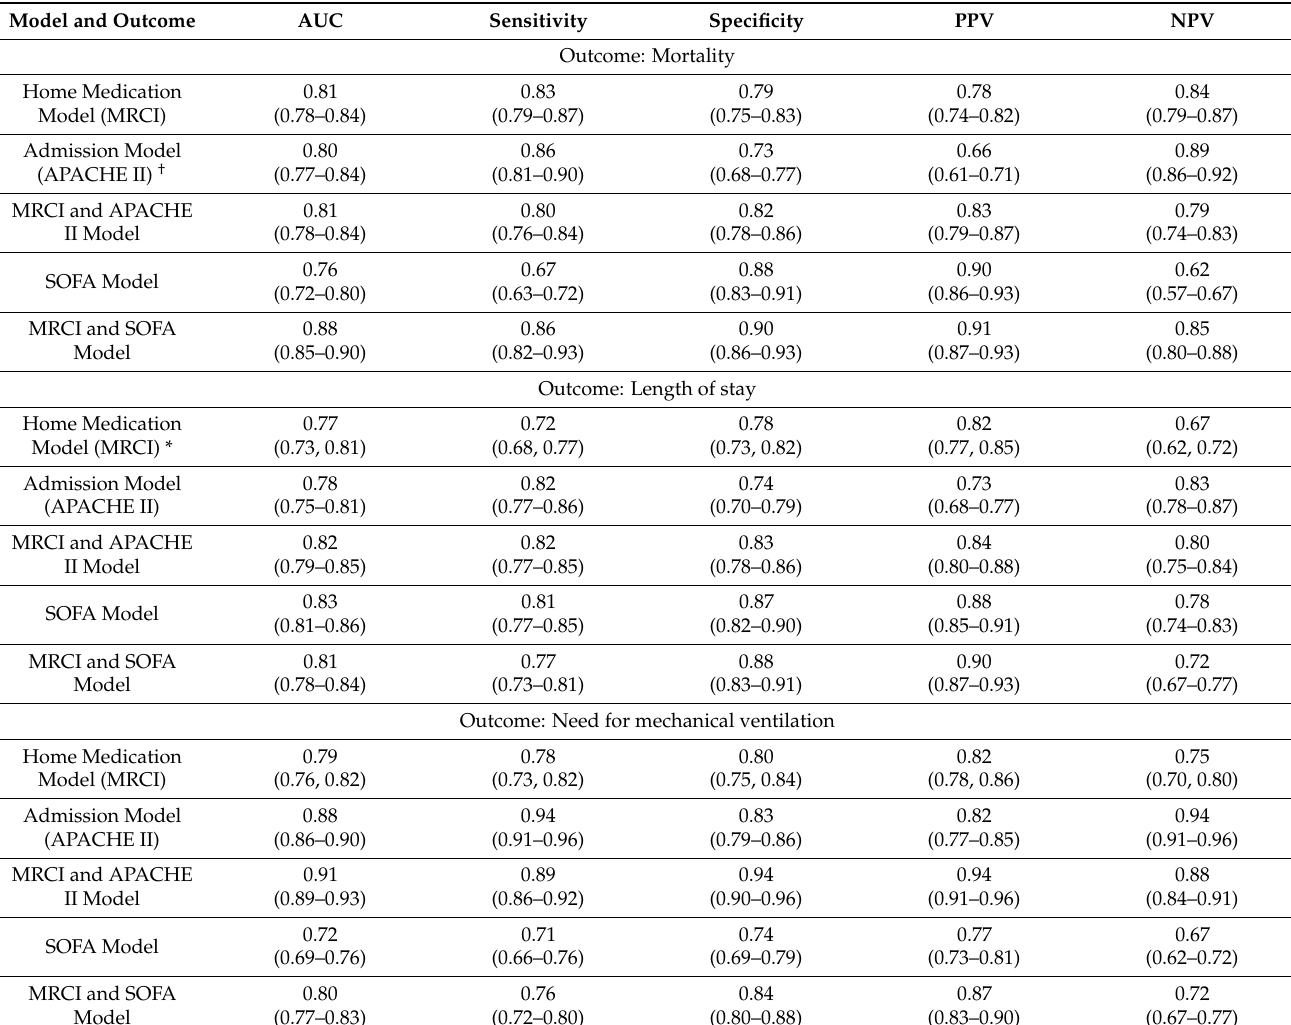
Table 3. Performance of machine learning algorithms across several models and outcomes in a subpopulation of